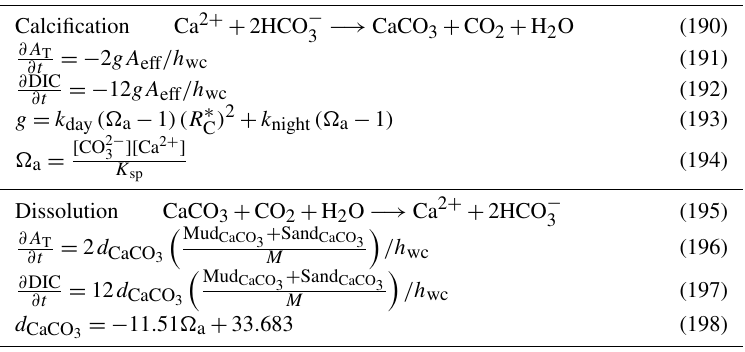
] , is determined from equilib- 3